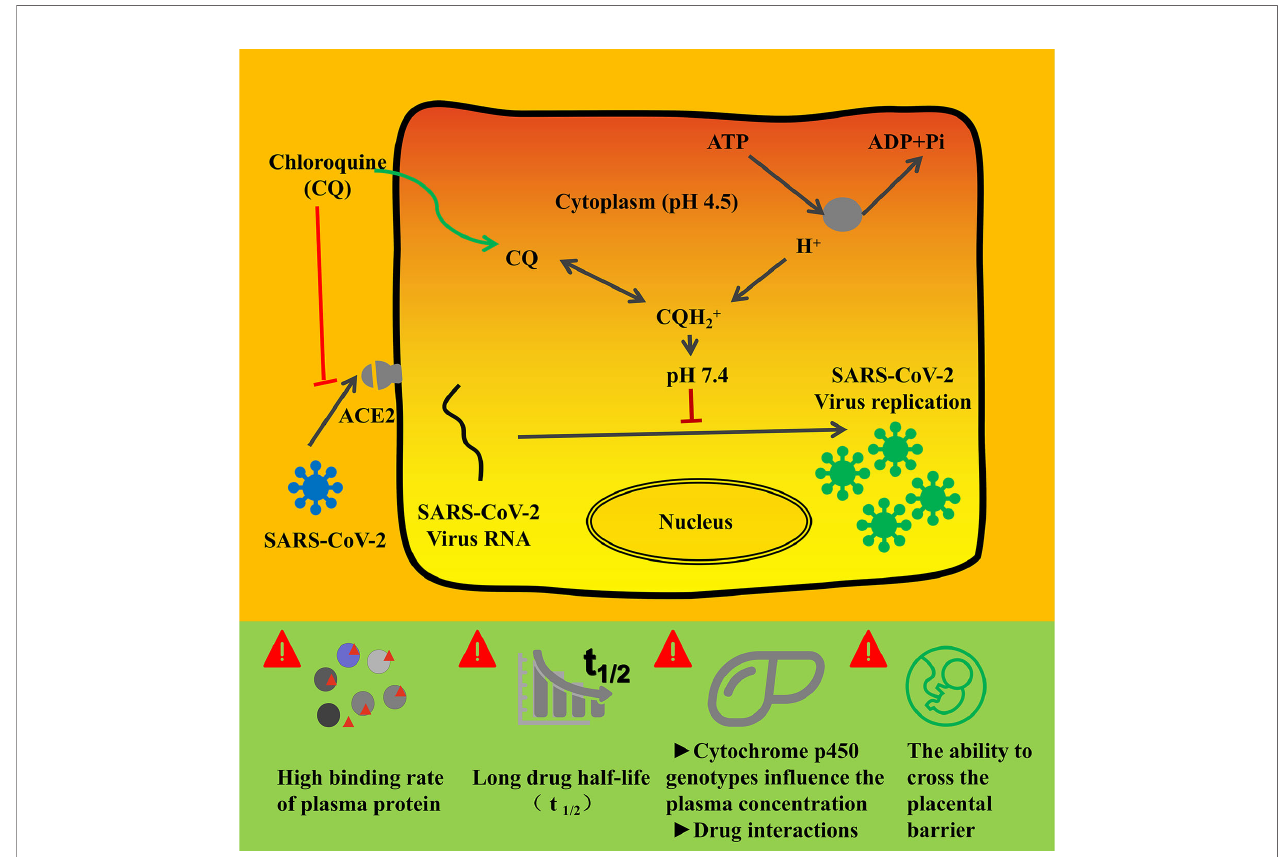
FIGURE 3 | The mechanism of chloroquine and its analogs on the inhibition activity of COVID-19 (Clotilde et al., 2018; Hoffmann et al., 2020; Yao et al., 2020) and pharmacological considerations. COVID-19 infection depends on the host cell factors ACE2, which is the attachment receptor of the virus. After interfering with ACE2 and prime S protein, COVID-19 enter the host cytoplasm and initiate massive replication. Chloroquine and its analogs could inhibit the interaction between coronavirus and ACE2. On the other hand, CQ could increase the cytoplasm PH, which would hinder the virus entry and replication in host